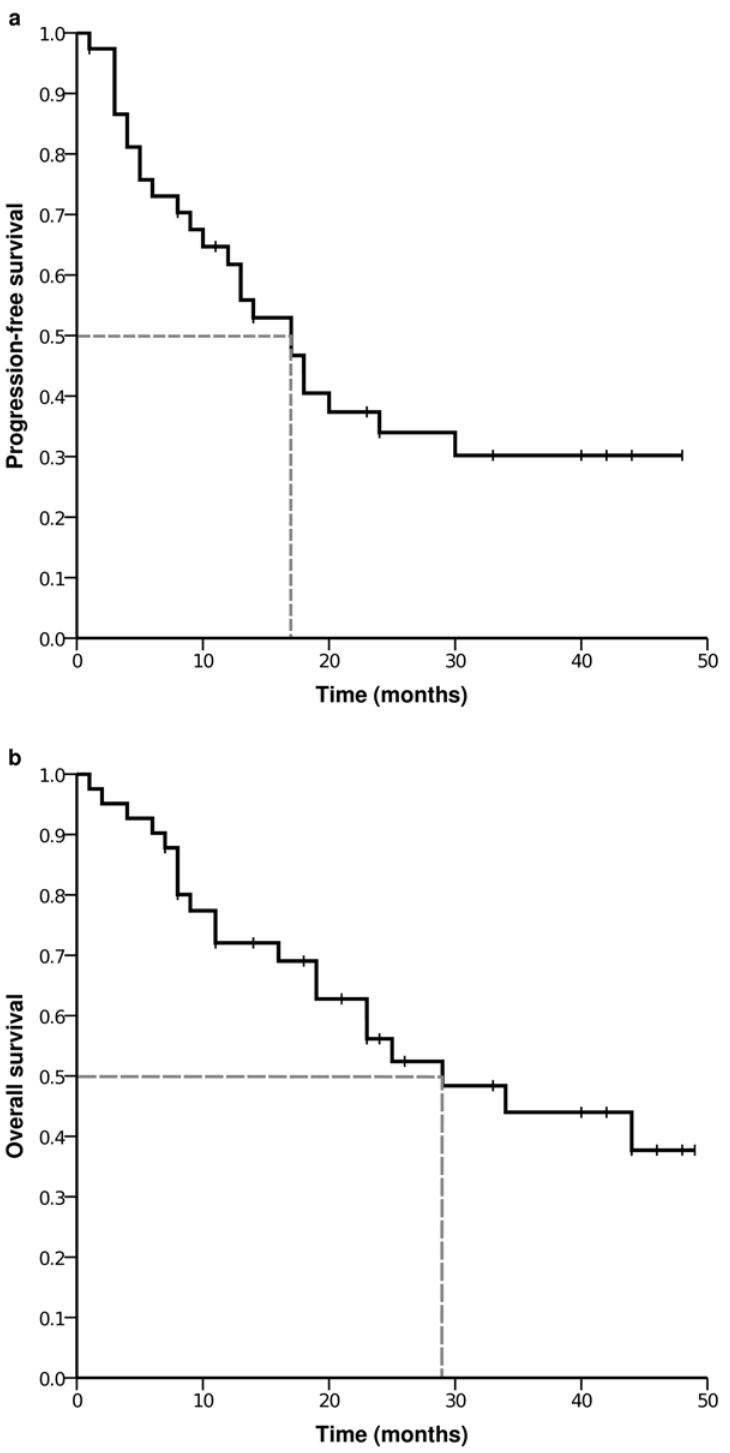
Fig 1. Kaplan-Meier plots of progression-free survival (a) and overall survival (b).